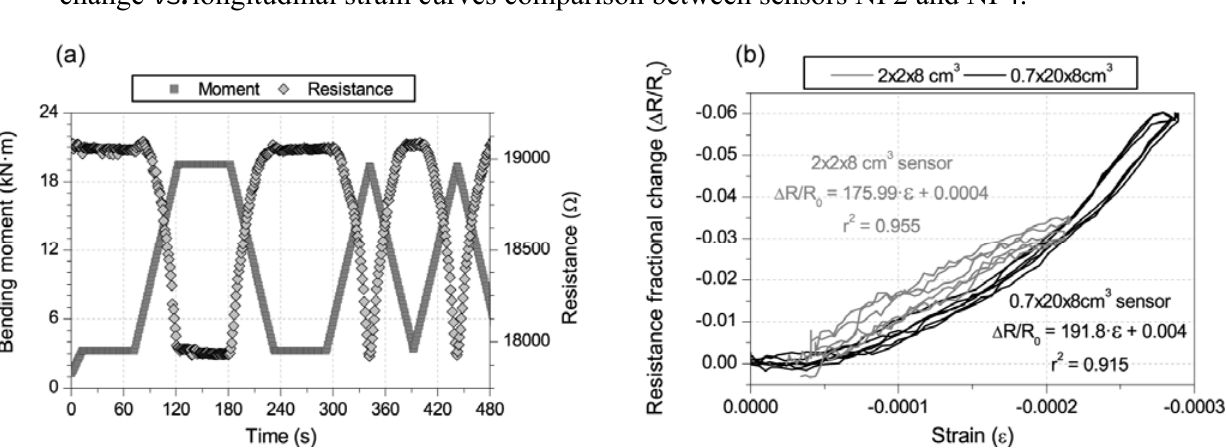
Figure 8. Comparison of 2% CNF (addition by cement mass) sensors: dimensions influence 2 × 2 × 8 cm³ vs. 0.7 × 20 × 8 cm³. ( a ) Electrical resistance and bending moment in the middle cross section vs. time for the 0.7 × 20 × 8 cm³ sensor; ( b ) resistance fractional change vs. longitudinal strain curves comparison between sensors NF2 and